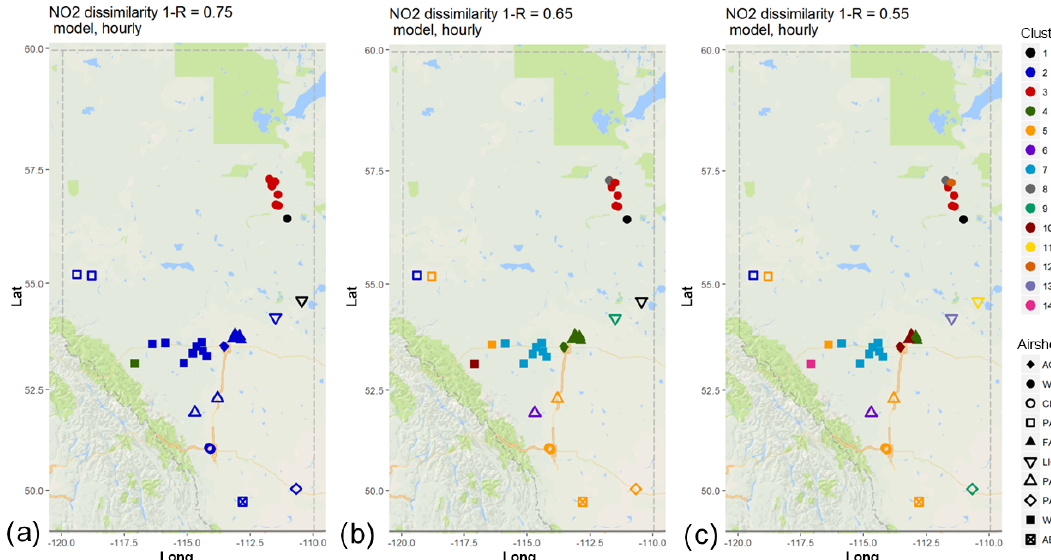
Figure 7. Associativity analysis for modelled NO 2 hourly time series using 1 − R as the metric to compute the dissimilarity matrix, assuming a dissimilarity level of (a) 0.75, (b) 0.65, and (c) 0.55. Stations are colour-coded according to cluster formation, and airsheds are plotted with different polygons. The acronyms for the airsheds are as in Fig.